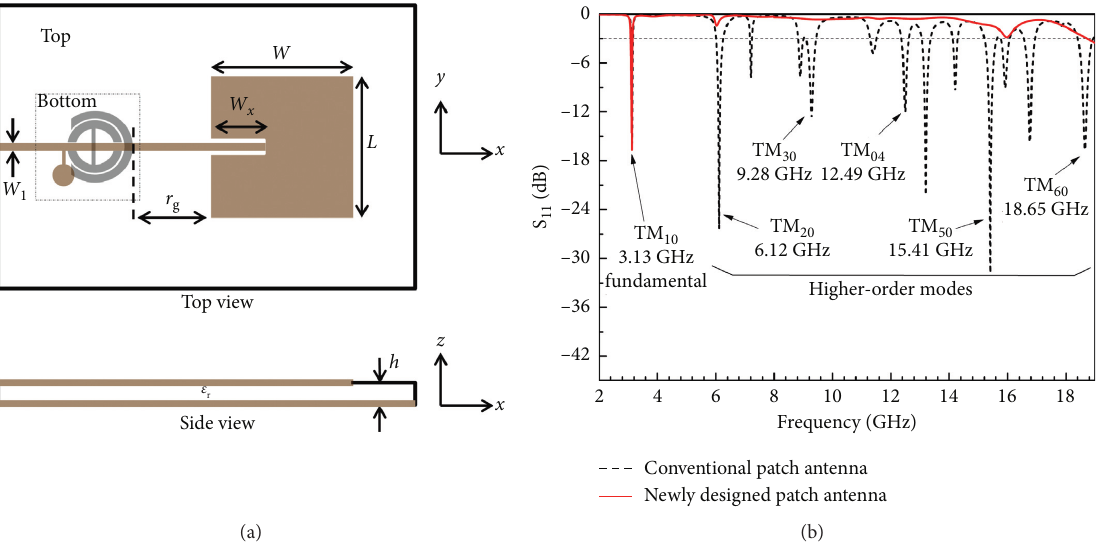
11 versus frequency for the conventional patch